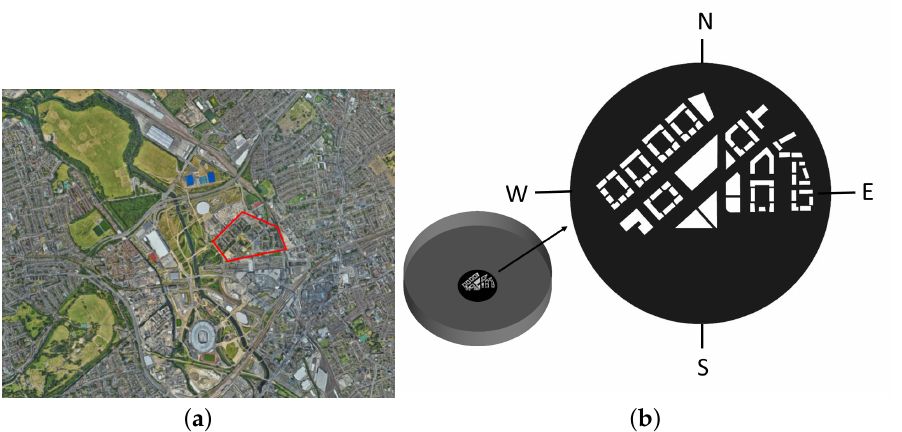
Figure 2. ( a ) The East Village location within the London Olympic Park. ( b ) The CAD model generated for the East